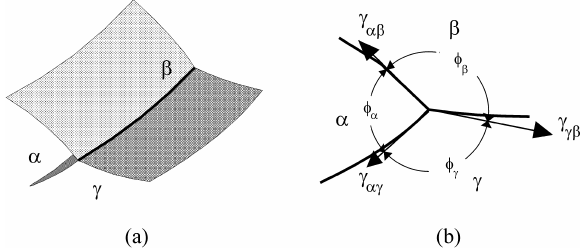
Figure 8. The condition for equilibrium at a triple line where three surfaces meet (a) determines the angle between the surfaces (b). These angles are measures of the tendencies for the phases to wet each other and may strongly influence the